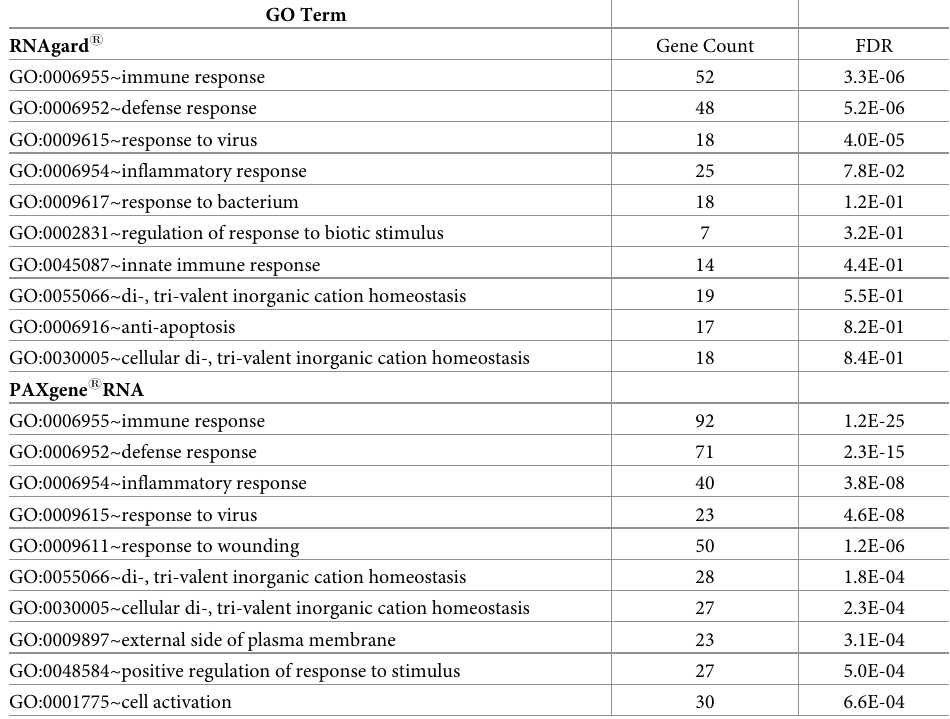
Table 3. Biological processes as indicated by specific Gene Ontology Id’s most highly associated with variable mRNA within RNAgard 1 and PAXgene 1 RNA preservation methods.